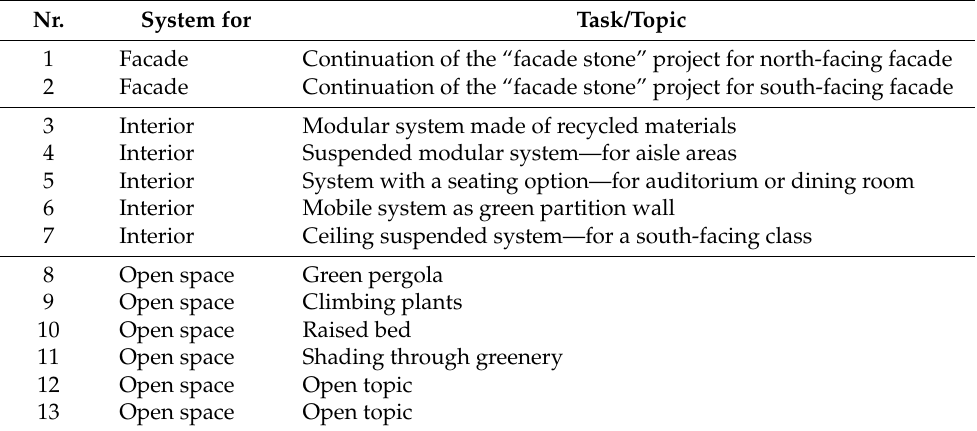
Table 2. Assignments for participating school classes to design low-cost greening systems for school interiors or open spaces.